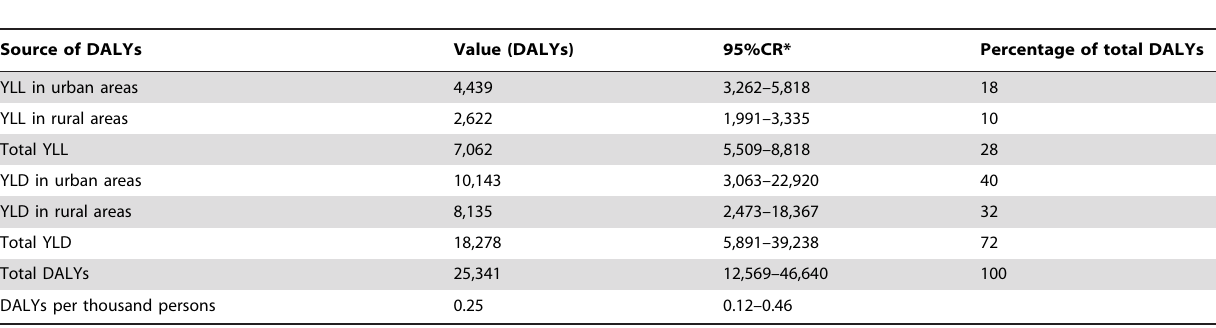
Table 5. Estimated annual number of DALYS due to NCC-associated epilepsy and severe chronic headaches in Mexico.